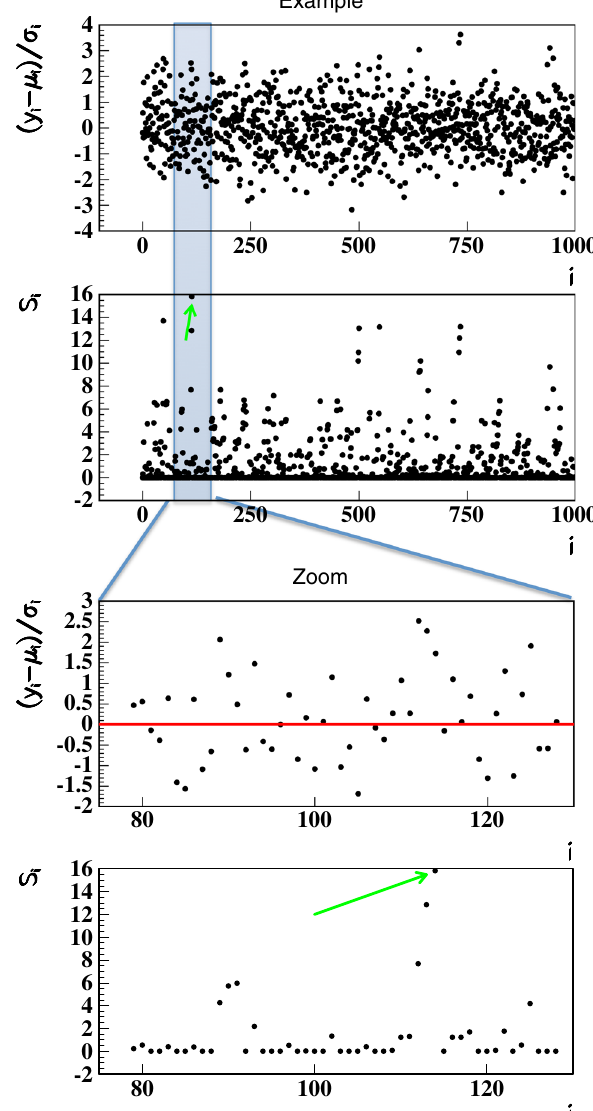
Fig. 1 A sequence of 1000 Gaussian distributed random numbers (shifted and scaled) is shown in the top plot, while the value S i of the current success run is shown in the second plot. A zoom in the region around the largest S i is shown below